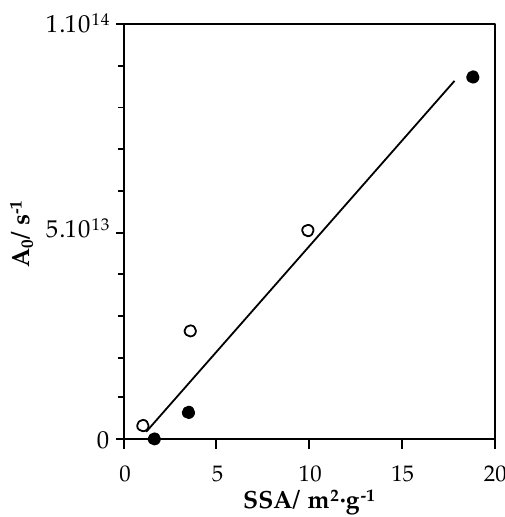
Figure 9. Evolution of corrected pre-exponential factors with catalyst surface areas. Open symbols: LaMn-compositions; Full symbols: LaFe-compositions.